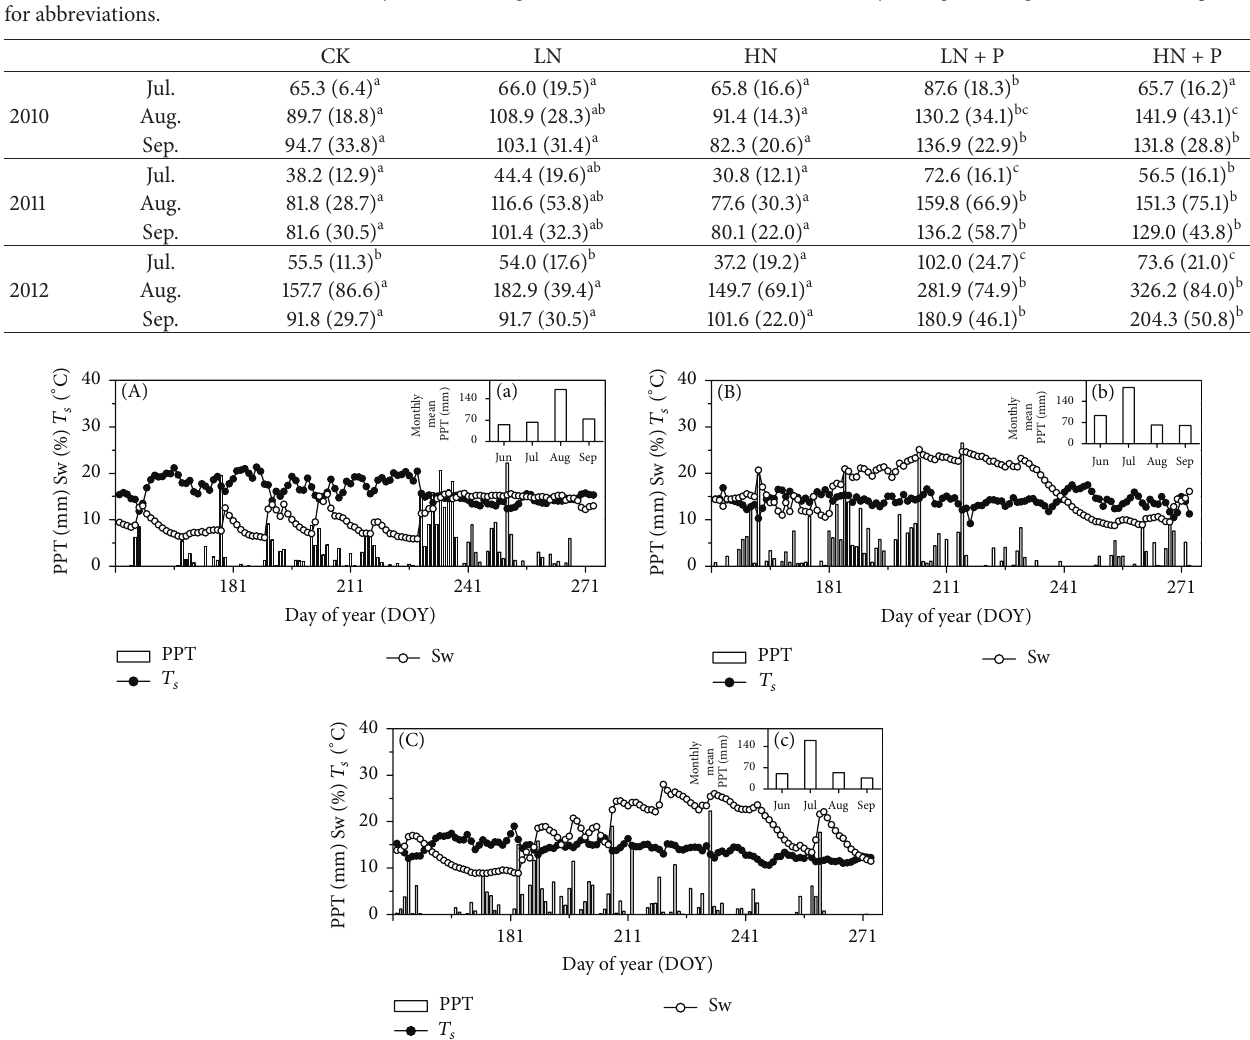
Figure 3: Daily precipitation (bars), daily mean soil temperature (line with solid circle), and moisture in 5 cm depth (line with open circle) from May to September in 2010 (A), 2011 (B), and 2012 (C). Precipitation in each month from June to September (in right up corner) was given in each